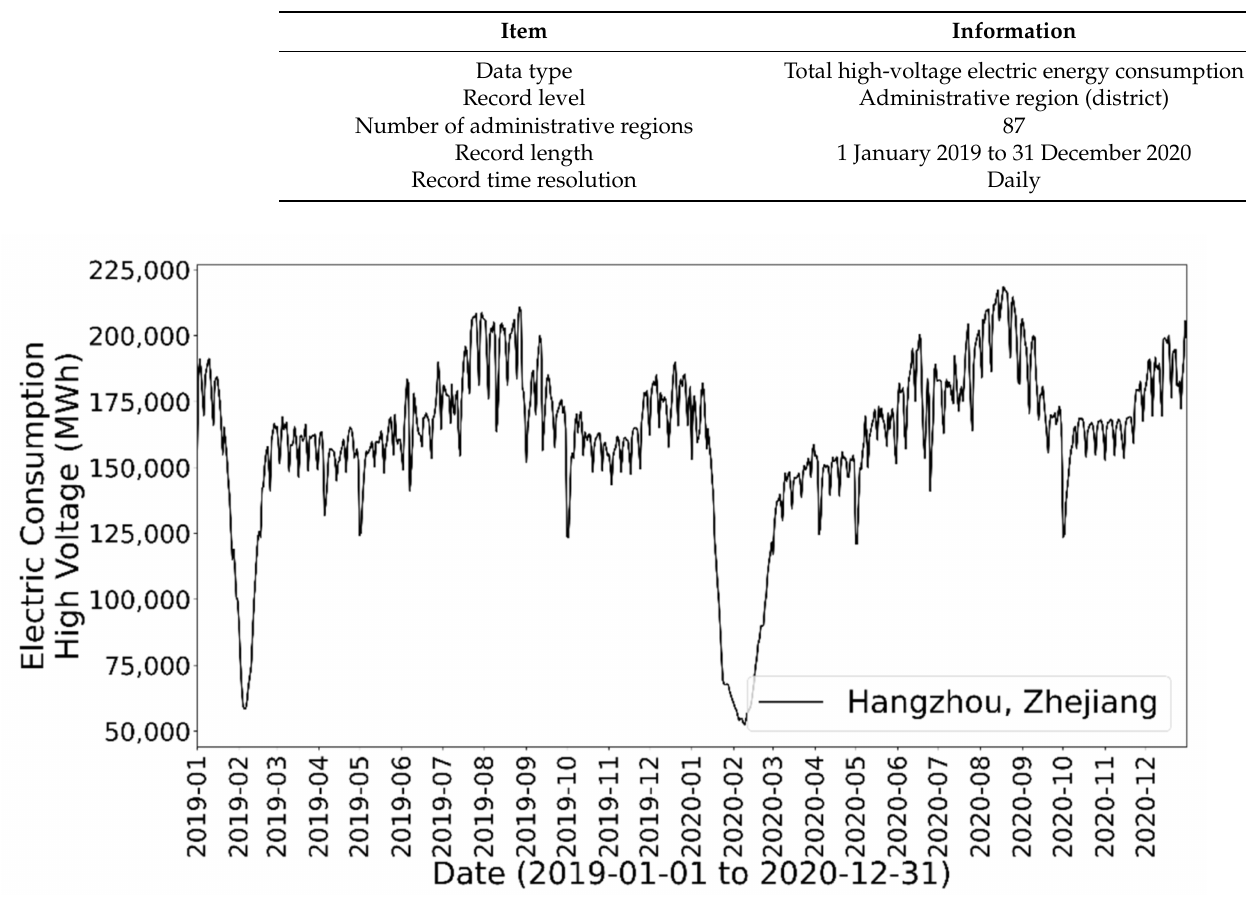
Figure 1. Daily high-voltage electricity consumption of Hangzhou (the capital city of the Zhejiang province) from 01